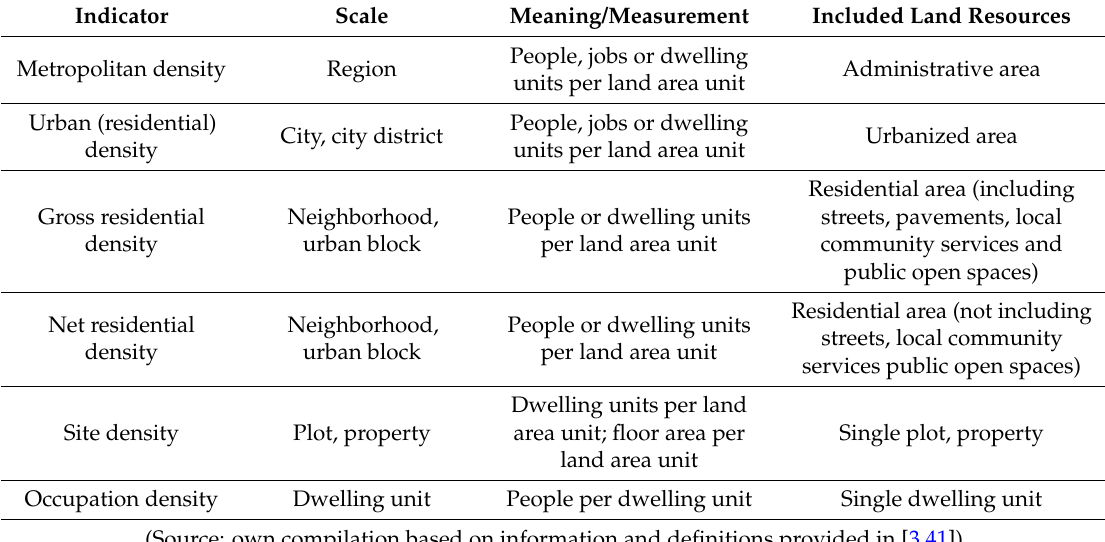
Table 1. Urban density indicators and their